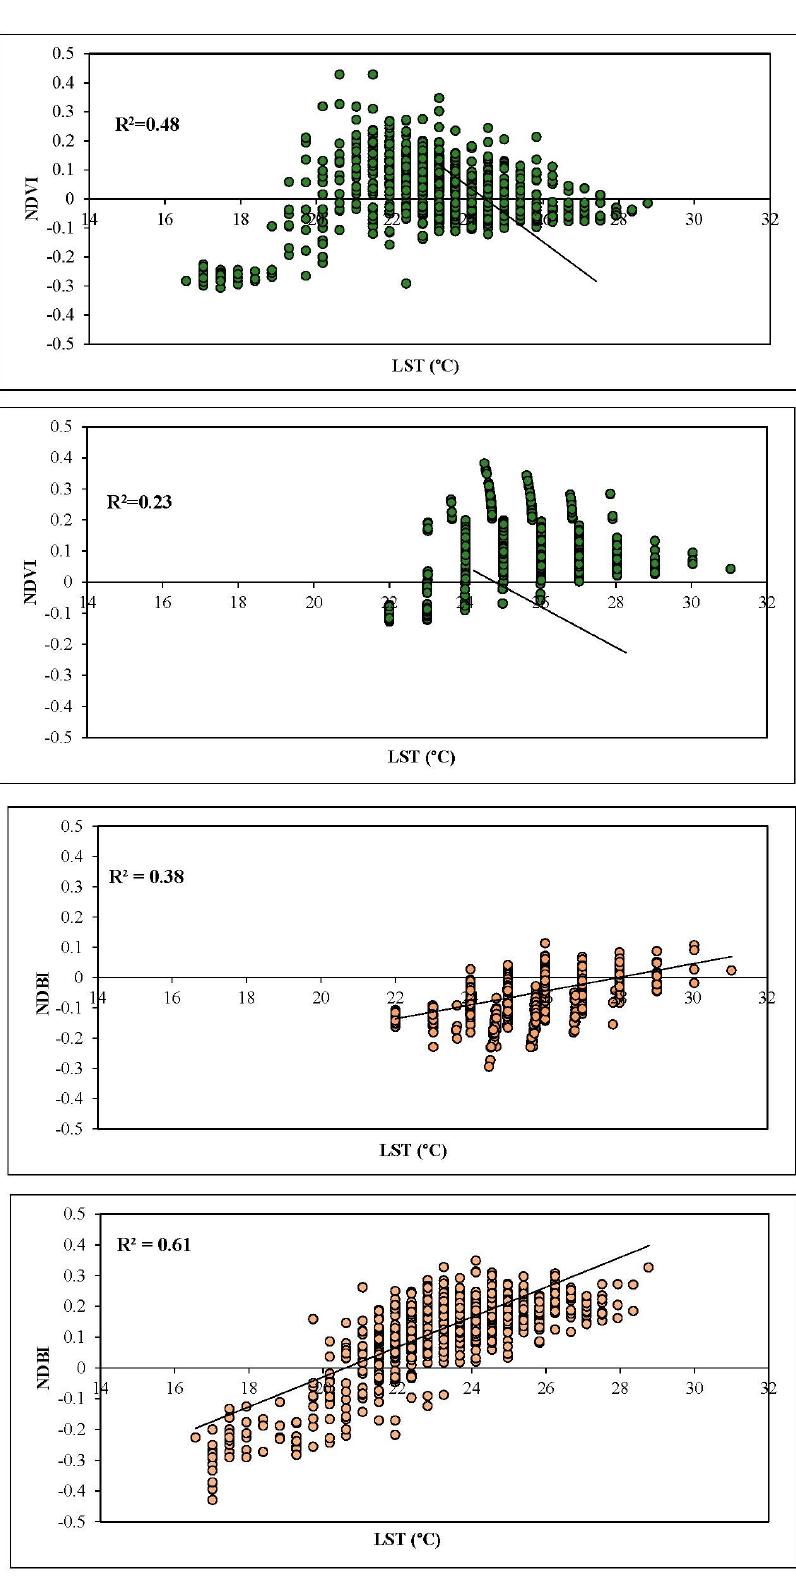
Figure 10. Correlation analysis between LST and spectral indices.